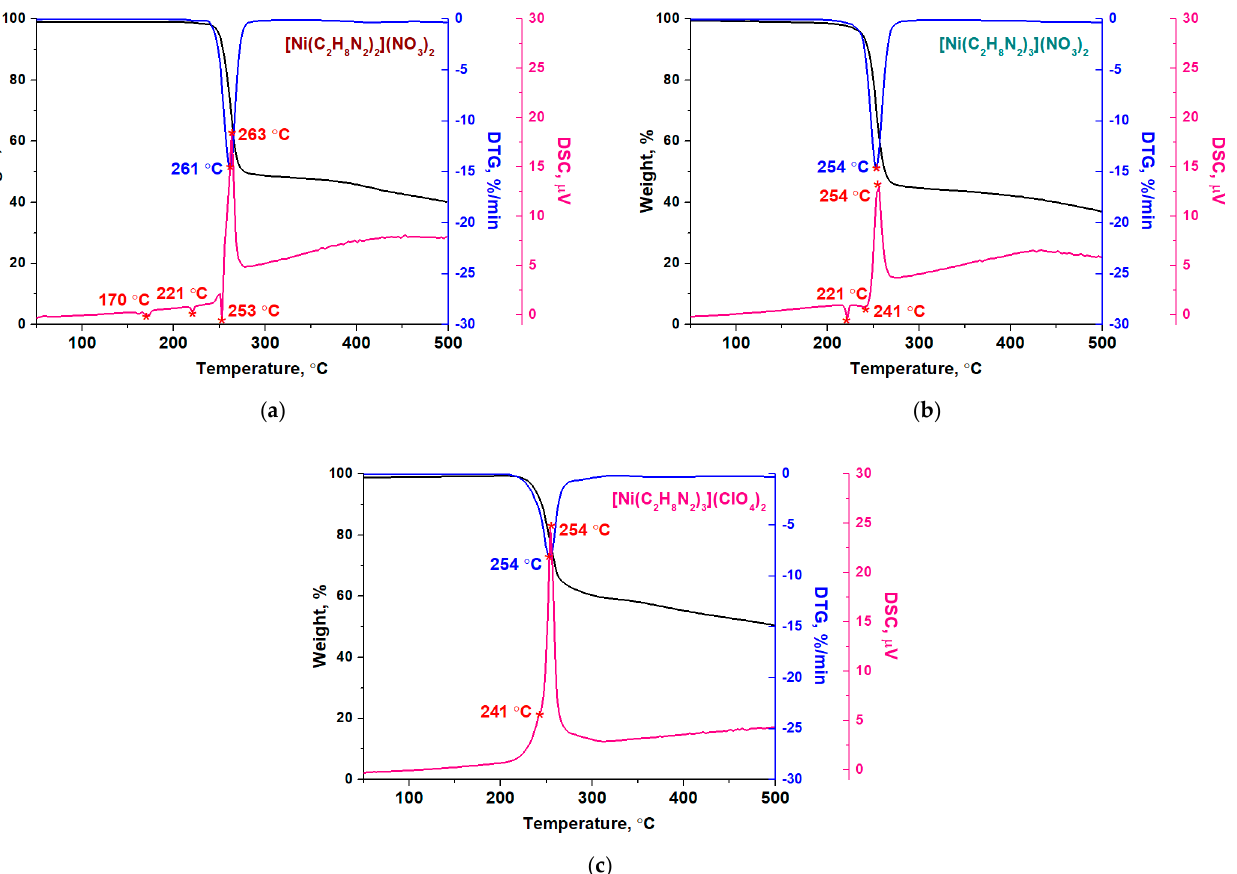
Figure 5. The thermal analysis data obtained for ( a ) [Ni(C 2 H 8 N 2 ) 2 ](NO 3 ) 2 , ( b ) [Ni(C 2 H 8 N 2 ) 3 ](NO 3 ) 2 and ( c ) [Ni(C 2 H 8 N 2 ) 3 ](ClO 4 ) 2 complexes (5 mg, helium, 20 mL·min − 1 , 5 °C·min − 1 ).